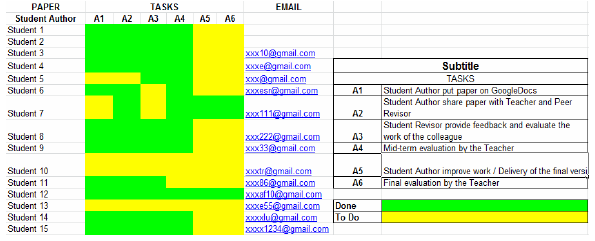
Figure 2. Management of the